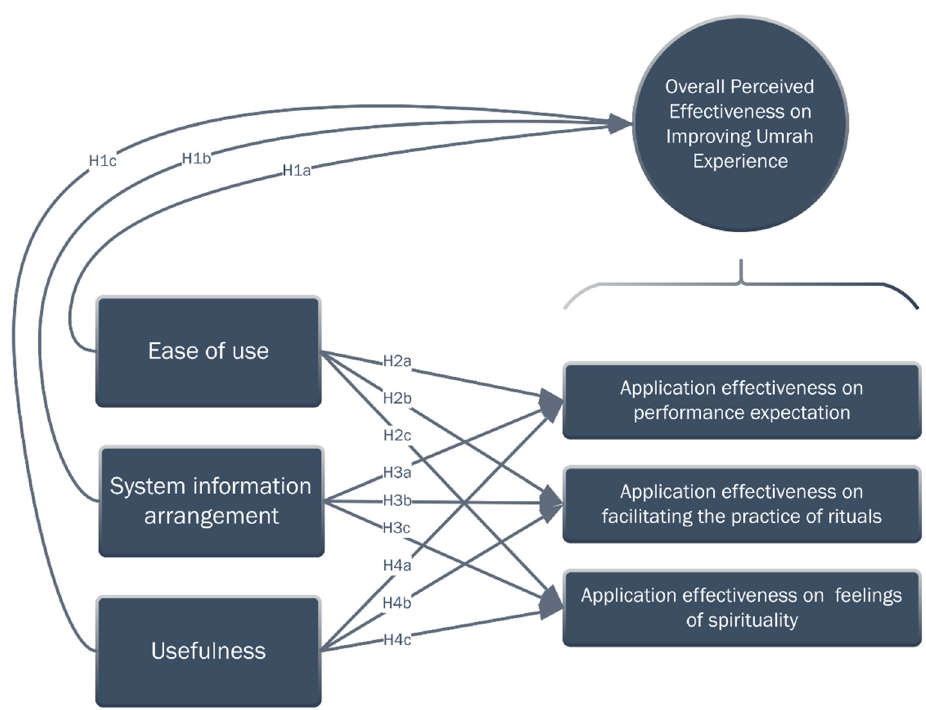
Figure 1. The hypothesized research